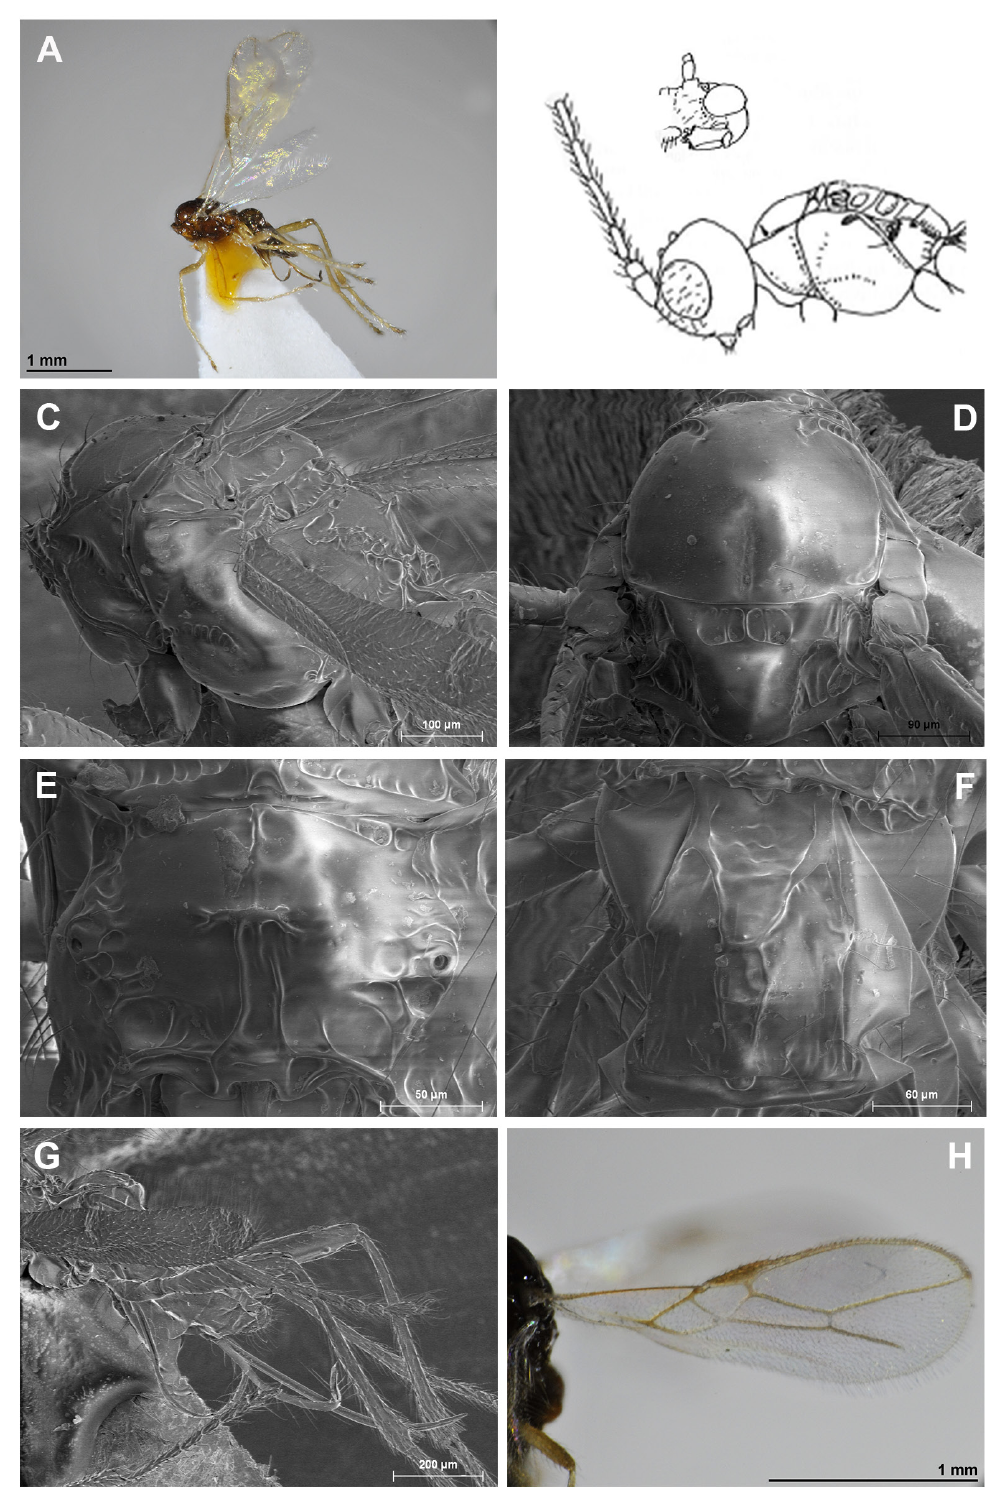
Fig. 45. Asobara nigerrima Fischer, 2003, ♀, holotype (NHMW). A . Habitus, lateral view. B . Head and mesosoma, lateral view (redrawn after Fischer 2003). C . Mesosoma, lateral view. D . Mesoscutum, dorsal view. E . Propodeum. F . First metasomal tergite, dorsal view. G . Hind leg, metasoma and ovipositor, lateral view. H . Fore